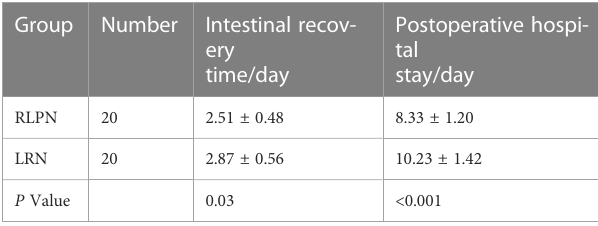
TABLE 3 The postoperative recovery of the